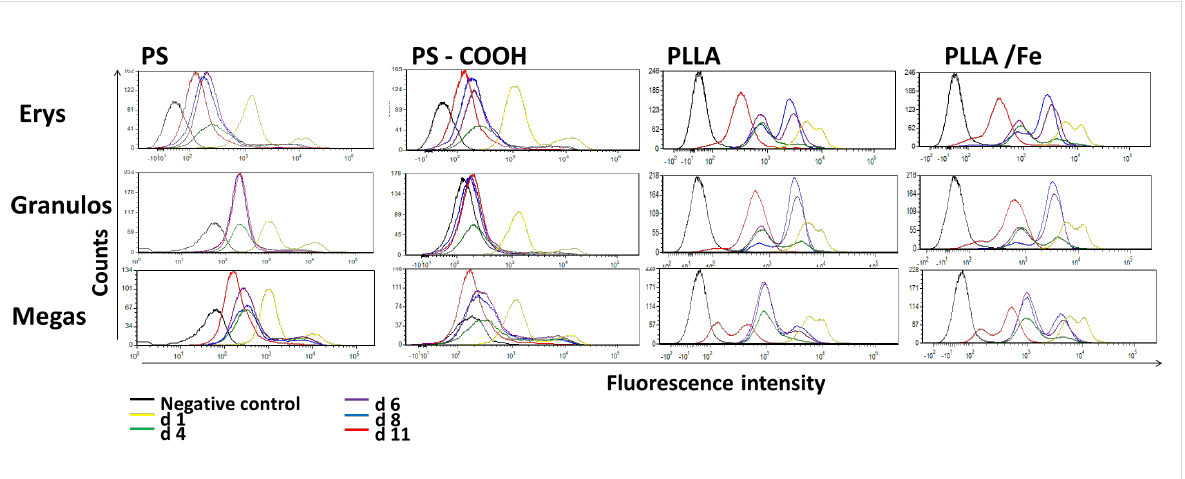
Figure 3: Particle uptake of hHSCs after 24 h incubation with 300 µg/mL nanoparticles. The nanoparticle content was measured every 2 days during differentiation time. Gating was based on FSC/SSC in order to exclude debris. Further gating was based on the differentiation markers for the erythro- cyte lineage (CD71, CD235a), granulocytic lineage (CD11b, CD15) and megakaryocytic lineage (CD41a,